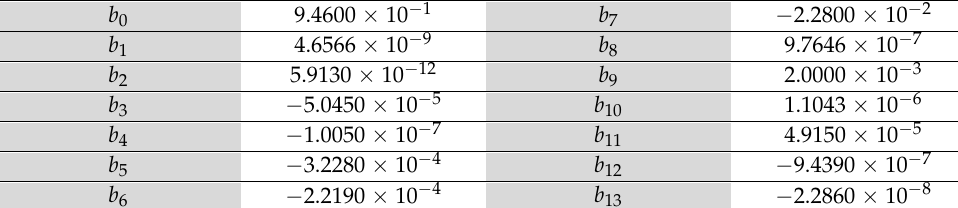
Table 3. Coefficient values of Equation (6).